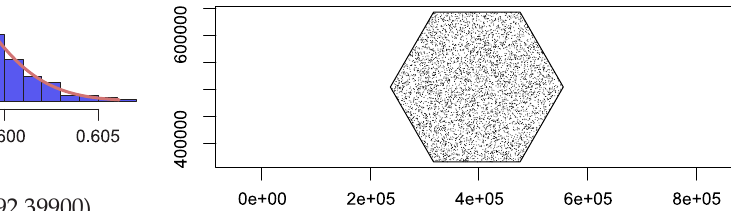
Fig. 5. Histogram and PDF for Γ(23692,39900) distribution. Source: own study.